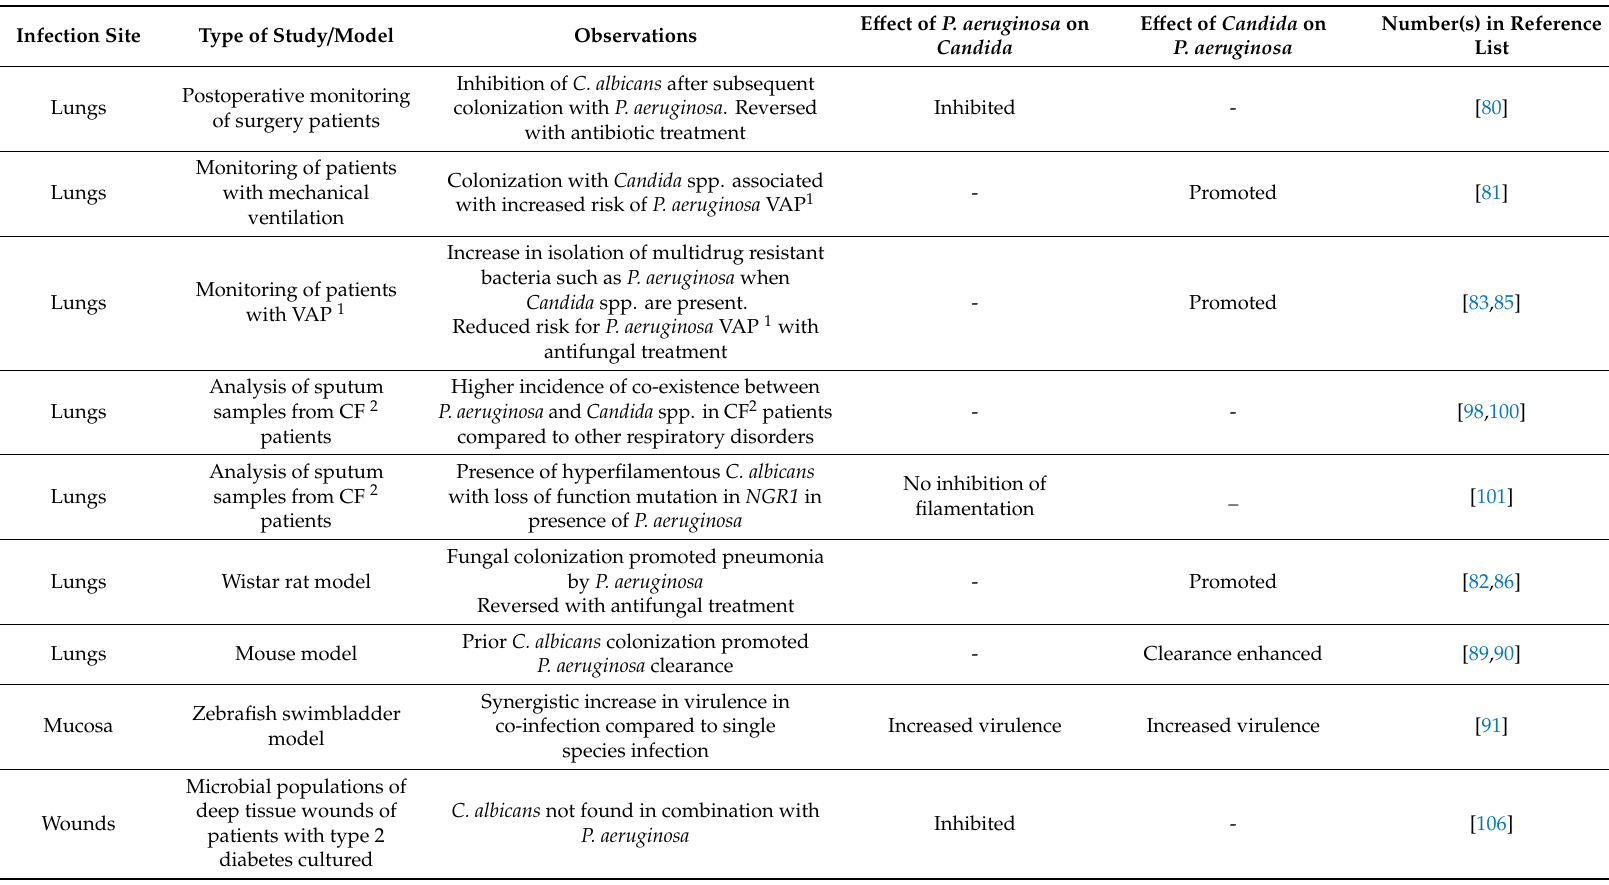
Table 1. Summary of the interaction between Candida spp. and Pseudomonas aeruginosa in vivo in various infection